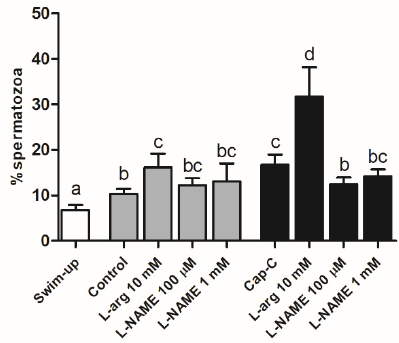
Figure 3. Percentage of live sperm with high nitric oxide levels (PI- / DAF + ) assessed by flow cytometry before (swim-up, white bars) and after in vitro capacitation without (control, grey bars) and with cAMP-elevating agents (Cap-C, black bars) and with L-arginine (L-arg, 10 mM) or L-NAME (100 µ M or 1 mM). Data are shown as mean ± S.E.M. ( n = 6). Different letters indicate significant differences ( p <